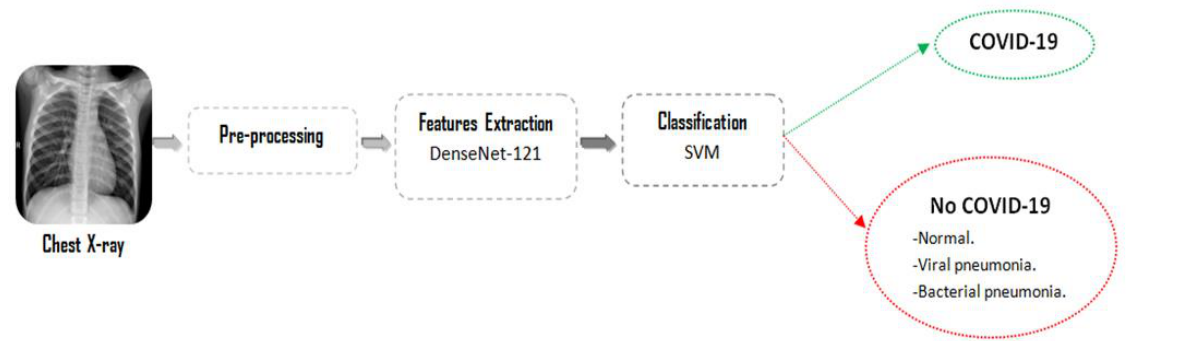
Figure 2. The proposed model pipeline.